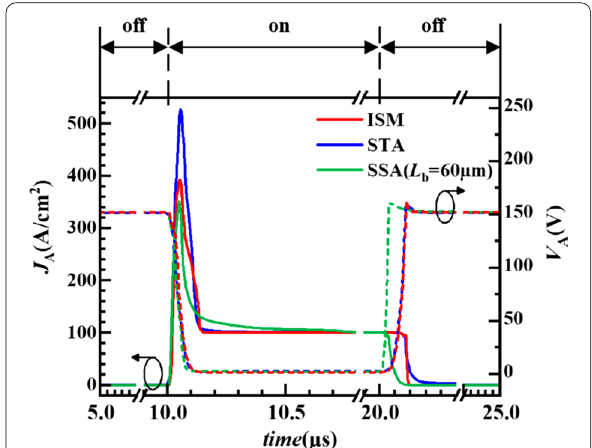
Fig. 11 The waveforms of the ISM RC-LIGBT, STA and SSA LIGBT in a complete switching cycle ( L C